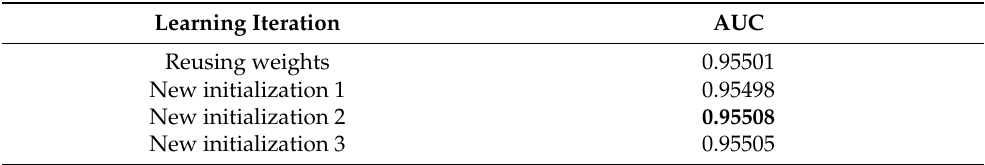
Table 4. MS-model results. New initialization indicates that the model weights were generated by Xavier initialization from a newly chosen random point.